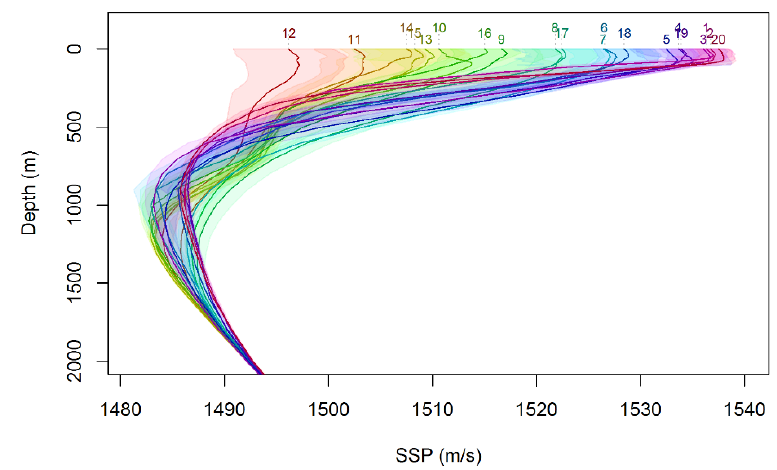
Figure 6. Sound speed profiles representative of the month of July, coloured by zone. The mean profile for each zone is drawn as a line on top of all profiles within that zone, which are merely shaded. Table 2. Interpretation of zones given by the